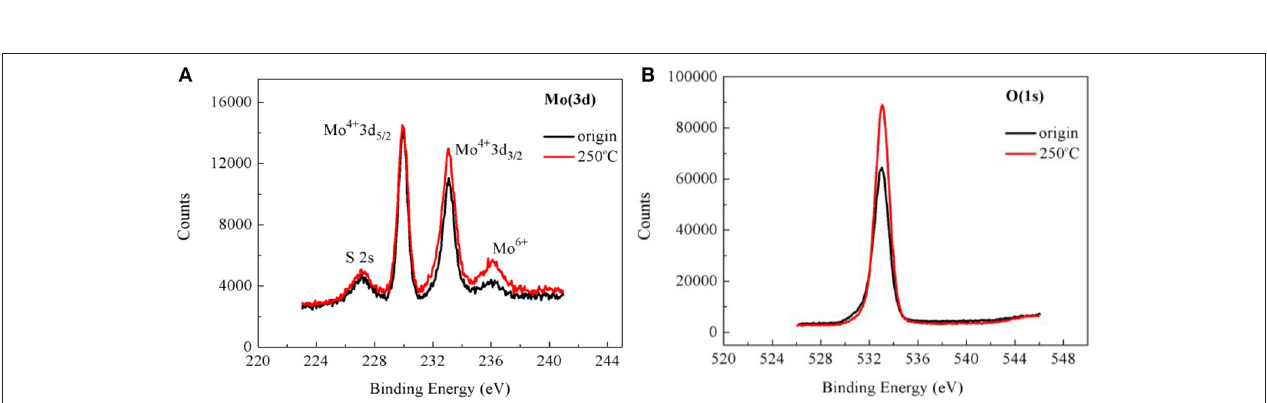
FIGURE 3 | (A) Raman spectra of the samples before and after baking at different temperatures for 2h under air. The wavelength number (B) and full width at half-maximum (C) of the A 1g and E 1 2g modes before and after baking at 150, 200, and 250 ◦ C for 2h under air.